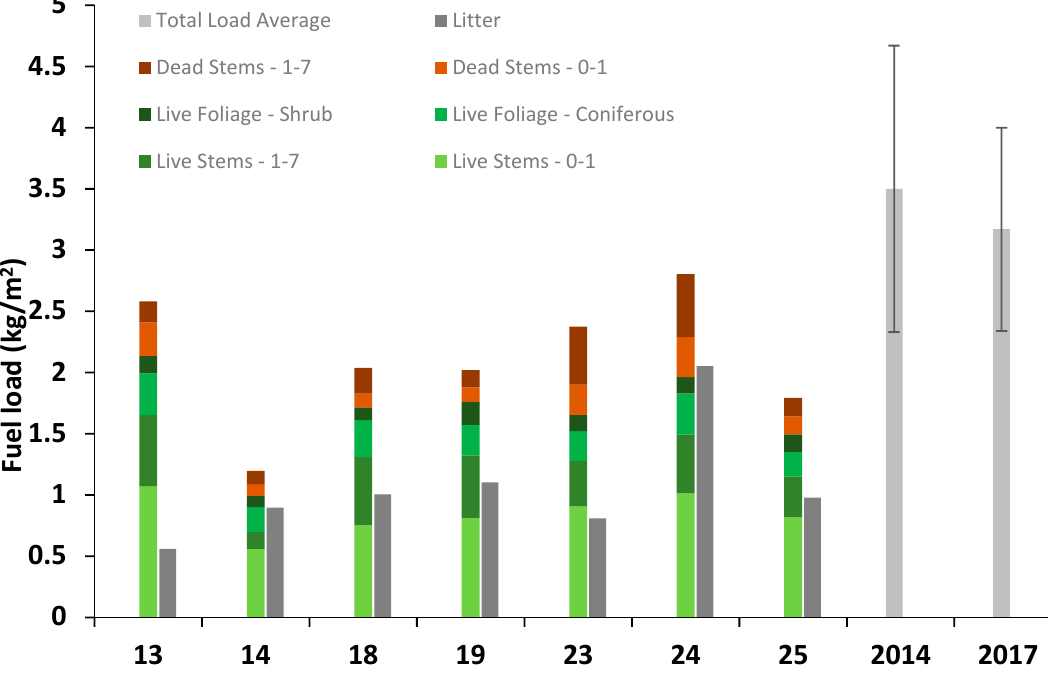
Figure 3. Fuel loading distribution by fuel complex component for study site 2014 and the more detailed plot specific sampling of each of the 2017 burn units.